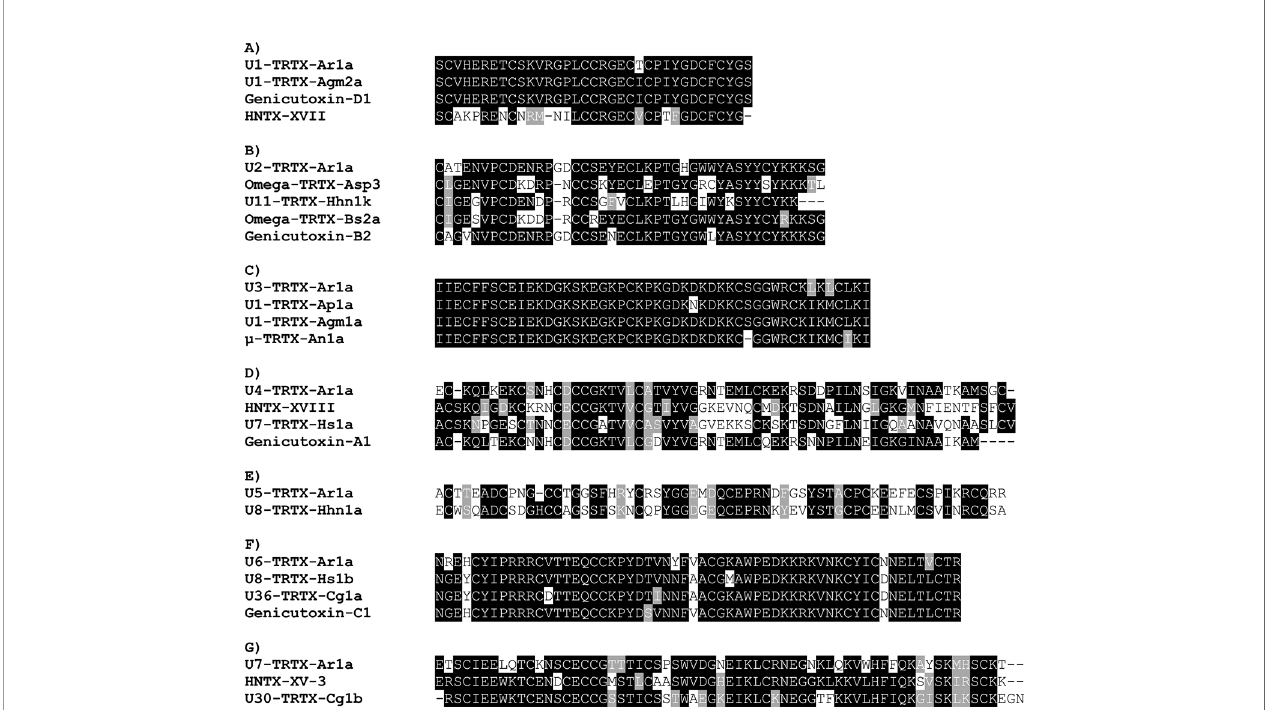
FIGURE 3 | Alignments of the seven families of CRPs validated in Acanthoscurria rondoniae peptidomic venom fraction with homologous toxins (>50% primary structure similarity) from other spider species. (A) U1-TRTX-Ar1a: A. rondoniae ; U1-TRTX-Agm2a: A. gomesiana (UniProt ID: P0DQJ4); Genicutoxin-D1: A. geniculata ; HNTX-XVII: Cyriopagopus hainanus (UniProt ID: D2Y2C5). (B) U2-TRTX-Ar1a: A. rondoniae ; Omega-TRTX-Asp3: Aphonopelma sp (UniProt ID: P0CI04); U11-TRTX-Hhn1k: Cyriopagopus hainanus (UniProt ID: D2Y281); Ω -TRTX-Bs2a: Brachypelma smithi (UniProt ID: B3FIV1); Genicutoxin-B2: A. geniculata . (C) U3- TRTX-Ar1a: A. rondoniae ; U1-TRTX-Ap1a: A. paulensis (UniProt ID: B3EWY4); U1-TRTX-Agm1a: A. gomesiana (UniProt ID: P0DQJ3); m -TRTX-An1a: A. natalensis (UniProt ID: B3A0P0). (D) U4-TRTX-Ar1a: A. rondoniae ; HNTX-XVIII: Cyriopagopus hainanus (UniProt ID: D2Y251); U7-TRTX-Hs1a: Cyriopagopus schmidti (UniProt ID: B3FIN4); Genicutoxin-A1: A. geniculata . (E) U5-TRTX-Ar1a: A. rondoniae ; U8-TRTX-Hhn1a: Cyriopagopus hainanus (UniProt ID: D2Y2C0). (F) U6-TRTX-Ar1a: A. rondoniae ; U8-TRTX-Hs1b: Cyriopagopus schmidti (UniProt ID: P82960); U36-TRTX-Cg1a: Chilobrachys guangxiensis (UniProt ID: B1P1J5); Genicutoxin-C1: A. geniculata . (G) U7-TRTX-Ar1a: A. rondoniae ; HNTX-XV-3: Cyriopagopus hainanus (UniProt ID: D2Y2B9); U30-TRTX-Cg1b: Chilobrachys guangxiensis (UniProt ID: B1P1I2).